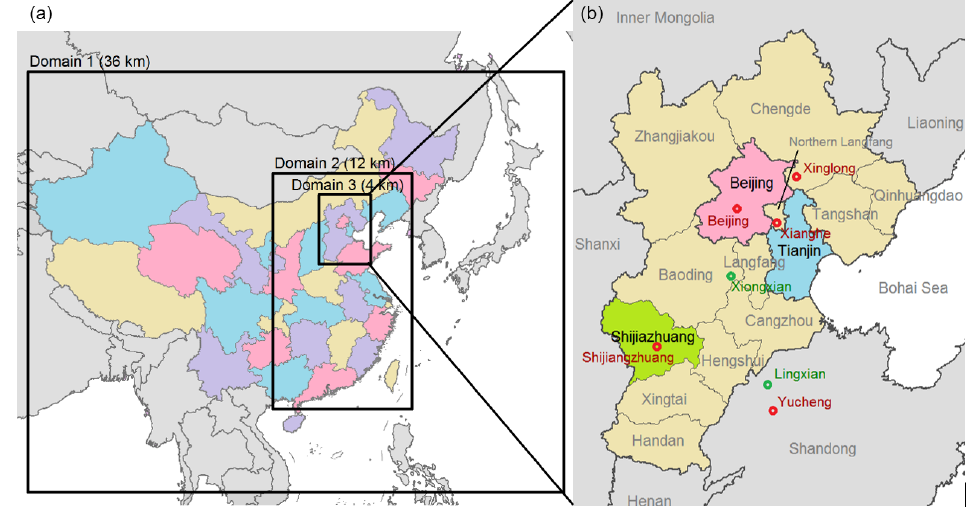
Figure 1. The simulation domains used in this study (a) and the map of the Beijing–Tianjin–Hebei region (b) . The highlighted cities are the target cities for flux calculation. The red circles show the sites with PM 2 . 5 observations. The two sites with green circles have observations of PM 2 . 5 chemical components in